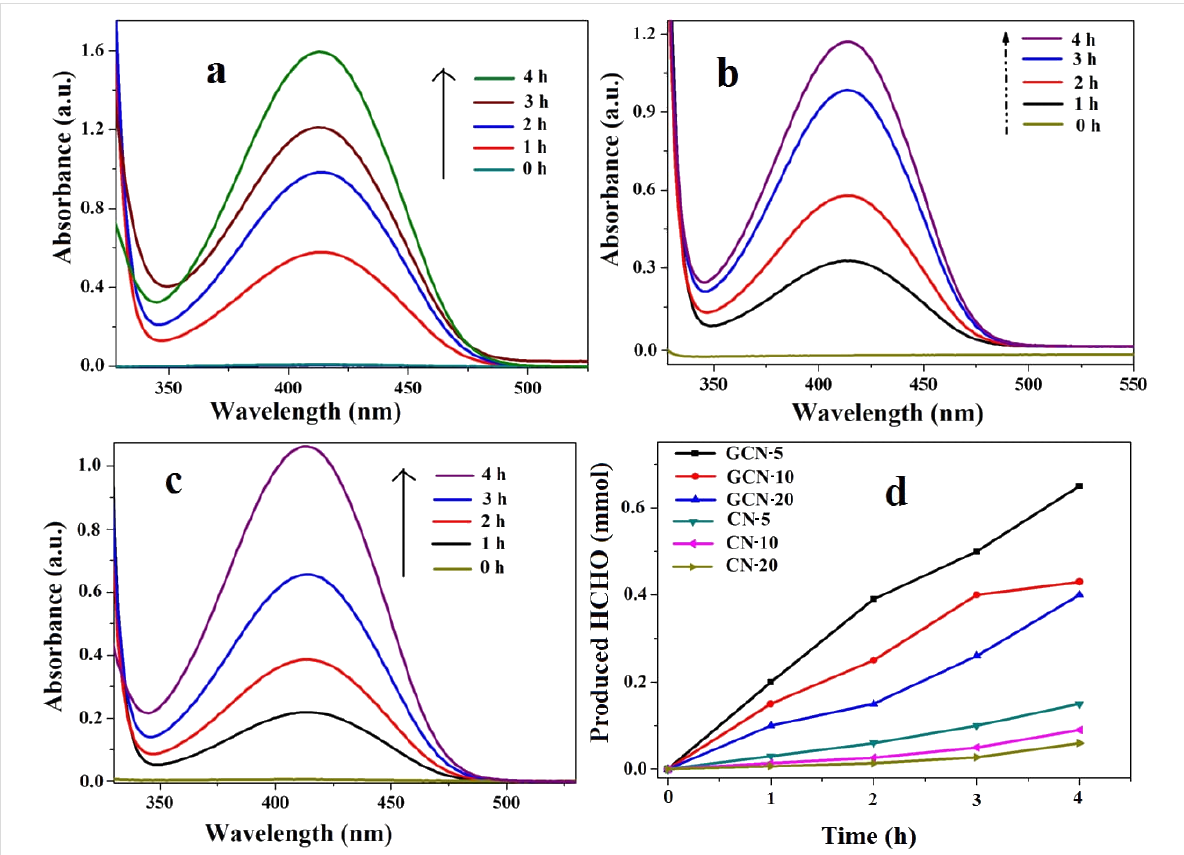
Figure 10: UV–vis absorption spectra of the photogenerated HCHO with Nash reagent (a–c), and (d) production rate of HCHO in the presence of dif- ferent GCN photocatalysts.